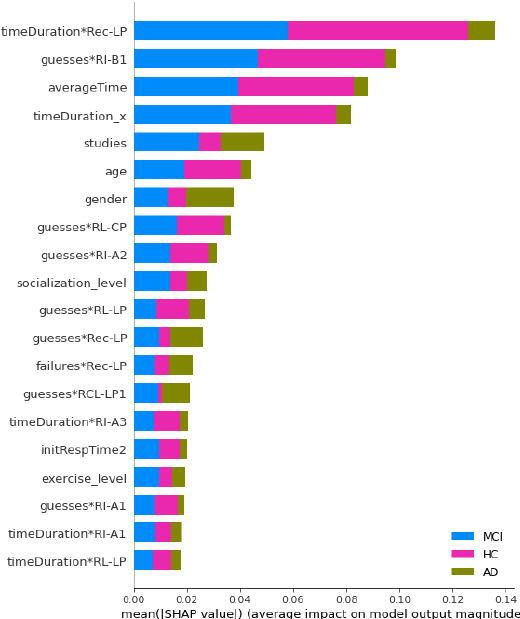
Figure 1. SHAP values about importance’s features for cognitive classes. Electronics 2022 , 11 , x FOR PEER REVIEW